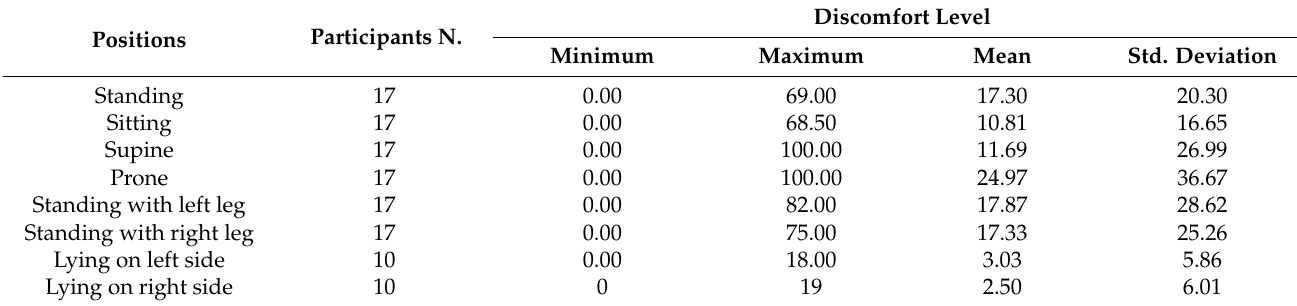
Figure 5. Distribution of the discomfort intensity of 17 participants in all positions.